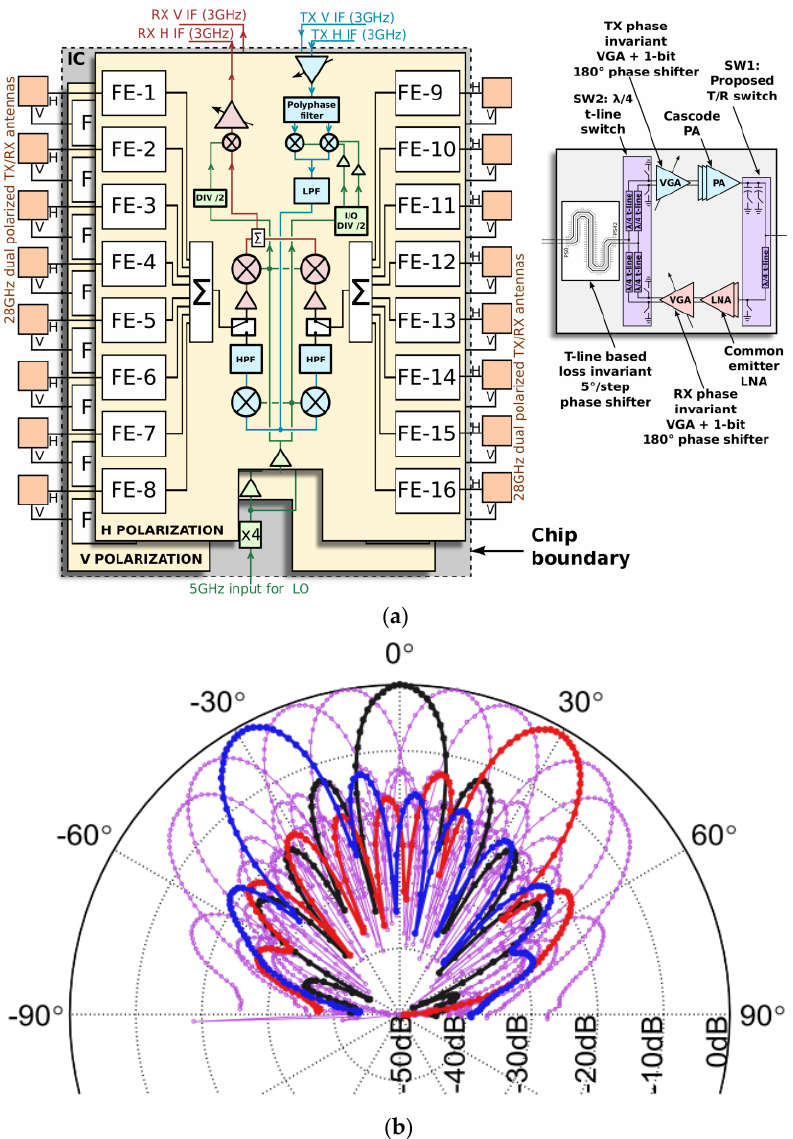
Figure 19. ( a ) RFIC architecture and schematic block diagram of 16 ‐ element phased array. ( b ) 64 ‐ ( a ) RFIC architecture and schematic block diagram of 16-element phased array. ( b ) 64-element TX phased-array angular beam-scanning of ± 50 ◦ (Redrawn from